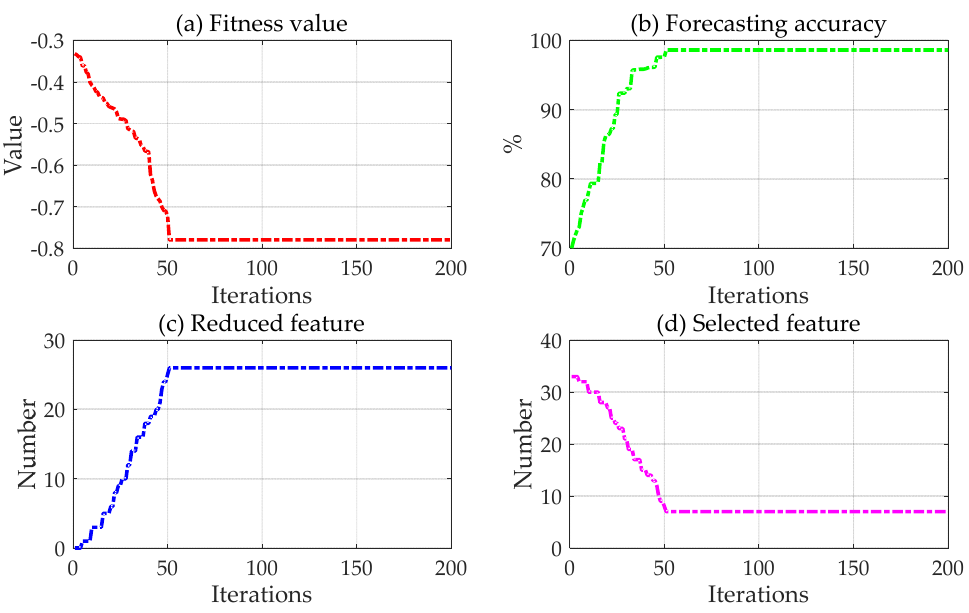
Figure 4. Convergence curves for feature selection. Note: ( a ) represents the fitness value, ( b ) represents the forecasting accuracy, ( c ) represents the reduced number of candidate feature, and ( d ) represents the selected number of optimization feature.